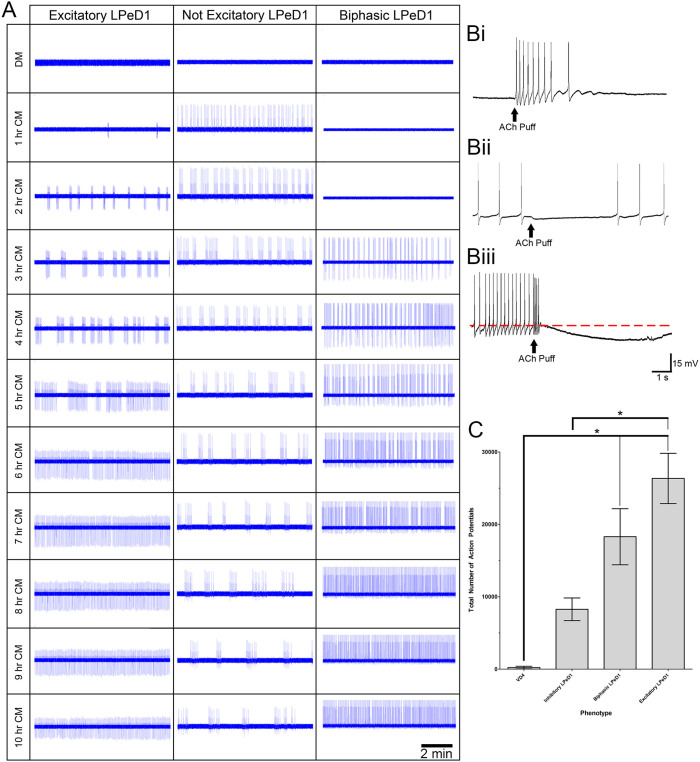
Total number of action potentials versus final functional AChR phenotype.(A) The activity triggered in response to conditioned media was different for all three phenotypes of isolated LPeD1 neurons. The figure shows 10 minutes samples of activity observed at various time points following CM exposure. Three different LPeD1 phenotypes were deciphered by neuronal responses to exogenously applied acetylcholine, which elicited 3 different effects, excitatory (Bi), inhibitory (Bii), and biphasic (Biii; elements of both excitation and inhibition). In (Bi), application of acetylcholine excited the cell, eliciting action potentials and increasing the frequency of activity. In (Bii), acetylcholine inhibited the cell, stopping the firing of action potentials and induced a decrease in neuronal membrane potential. In (Biii), acetylcholine elicited an action potential that was followed by a subsequent decrease in membrane potential (a pre-application potential line is shown as a red dotted line to aid in visualization). Acetylcholine applications are indicated by a solid arrow. The total LPeD1 activity is stratified according to neuronal response to acetylcholine application (C). It can be seen that cells with excitatory response had higher levels of activity than those that exhibited an inhibitory response. Significance is denoted with an asterisk (*) and is assumed if p < 0.05.